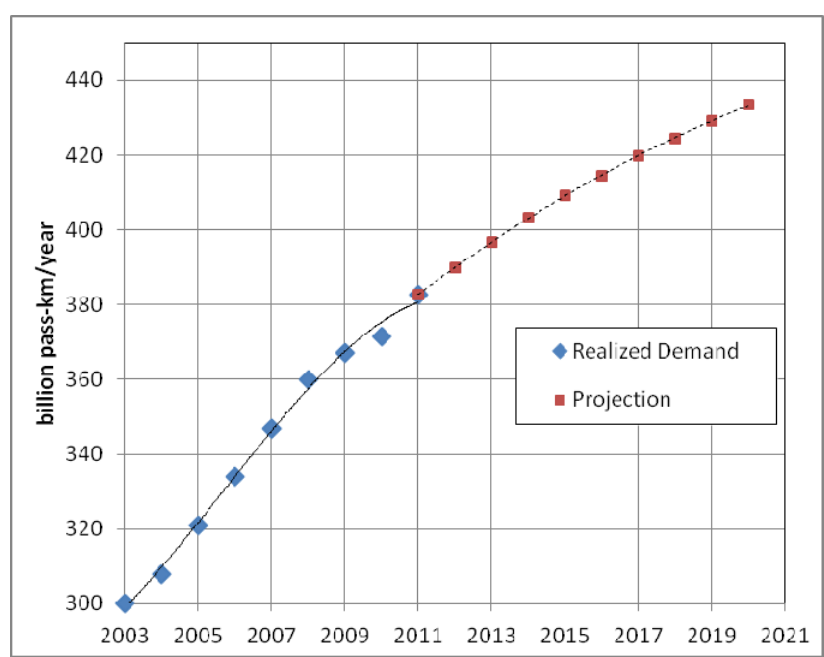
Figure A1. Forecasts of passenger demand